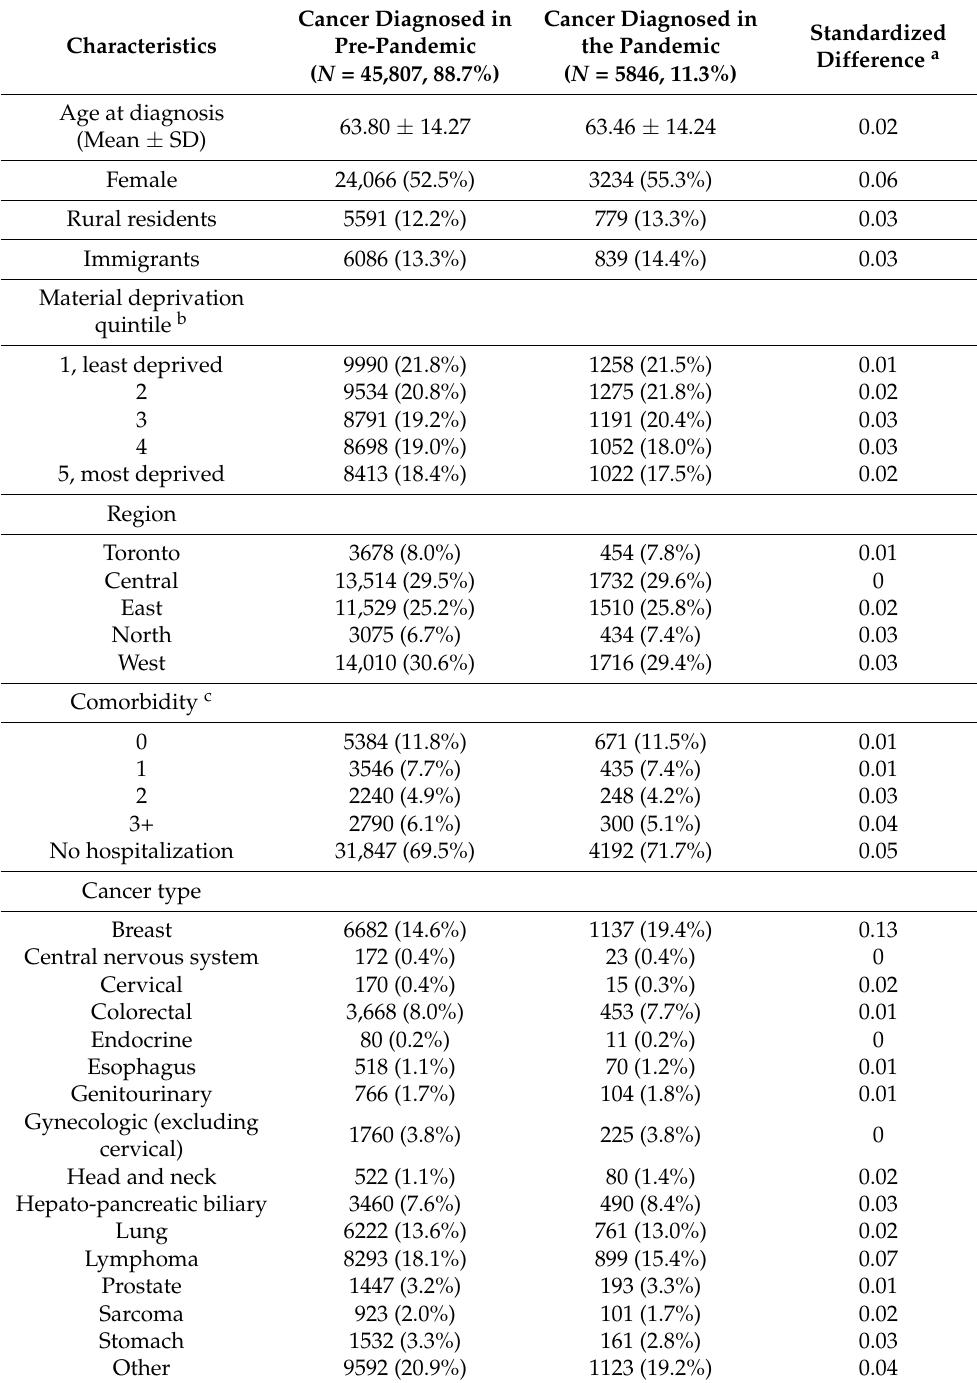
Table 1. Characteristics of patients receiving chemotherapy as the first cancer treatment within 6 months of diagnosis, stratified by COVID-19 period ( n =